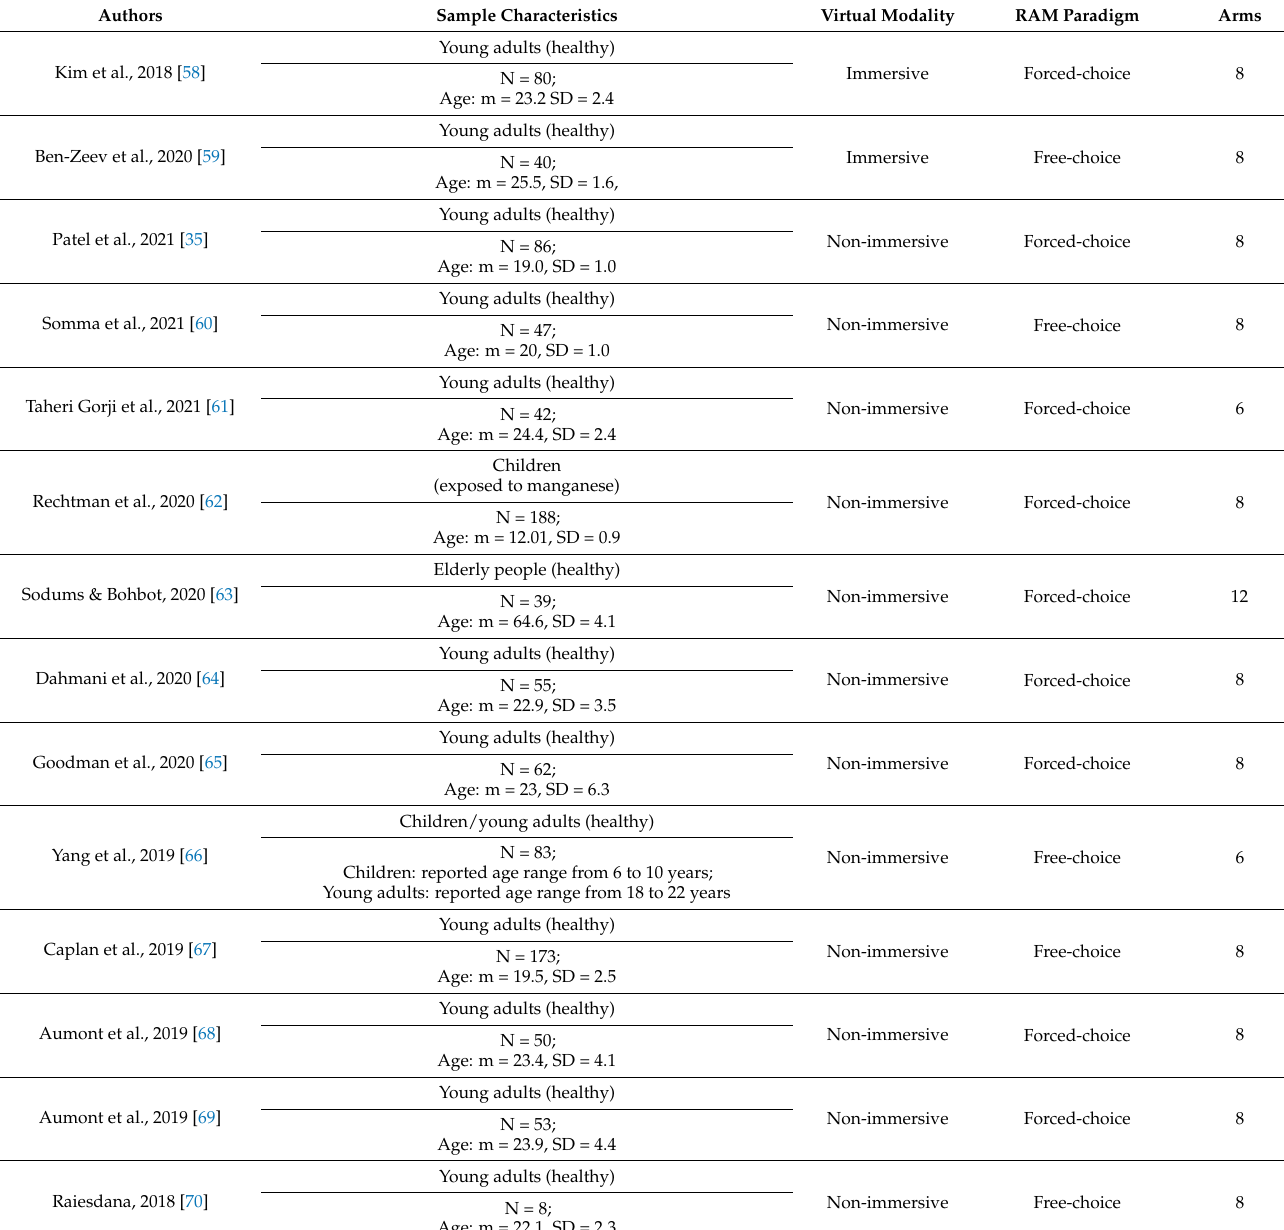
Table 2. Studies carried out using RAM in virtual